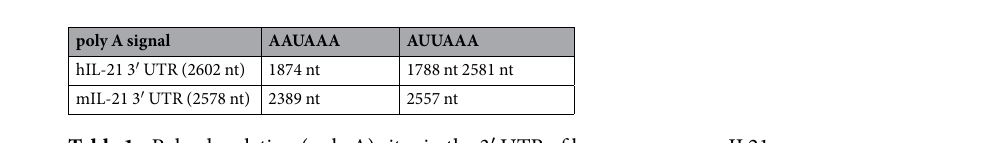
miR-221, and miR-222, which were in the top 25 miRNAs up-regulated by HBV infection. Previously the expres- sion of miR-21, miR-221, and miR-222 was reported to be increased in EVs from patients infected with HBV 24, 25 and miR-215 was also shown to increase in the serum derived from patients infected with HBV 37 . Notably, the expression levels of these miRNAs were increased along the progression of disease state. While the expression of miR-192 in patients infected with HBV was not reported, its expression in HepG2.2.15 cells was higher than paren- tal HepG2 cells 38 . In addition, previous reports show that Hepatitis B virus X protein (HBx) induces up-regulation of miR-21 and miR-221 39–41 . Although the mechanism by which the five miRNAs are increased in EVs are unknown, these previous studies indicate that the expression of the five miRNAs is increased by HBV infection.